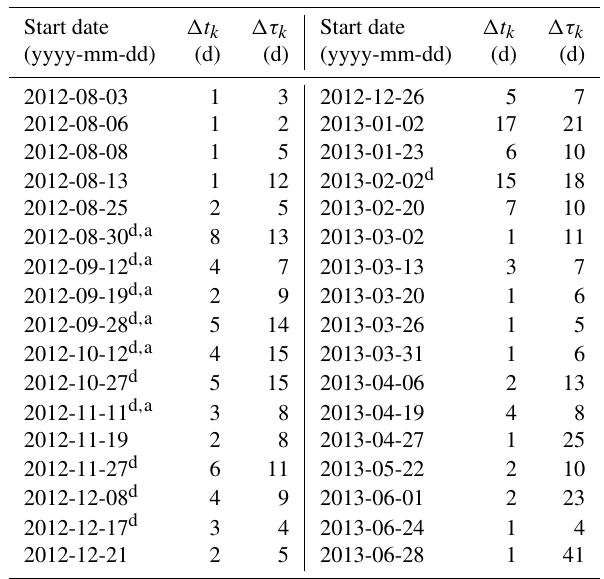
Table 1. The start date, duration ( (cid:49)t k ), and period between each event ( (cid:49)τ k ) for each Mistral event ( k ) for the entire NEMO simulation period of 1 August 2012 to 31 July 2013. Superscripts “d” and “a” denote events used as ideal cases for calculating α d and α a , respectively, in Sect. 4.3 and Appendix A2.1 and